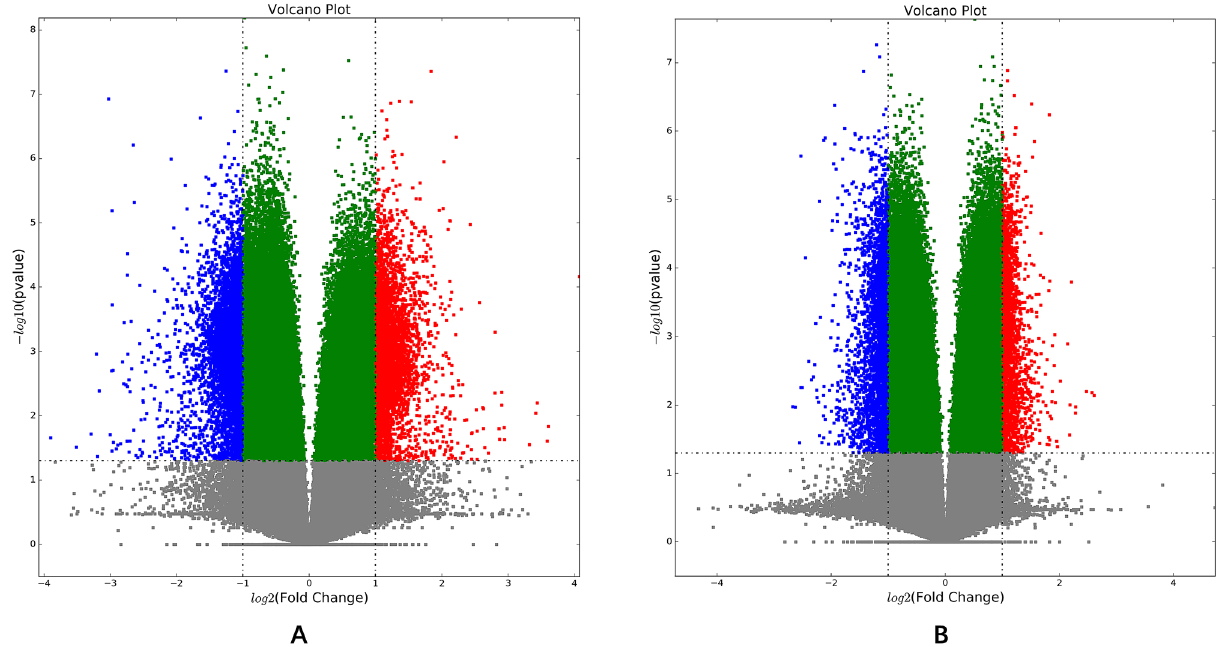
Figure 1. Volcano Plots. ( A ) Comparisons of differential DNA methylation sites between CD penetrating intestinal mucosal tissue with normal intestinal mucosal tissue; ( B ) Comparisons of differential DNA methylation sites between CD penetrating and non-penetrating intestinal mucosal tissue. Figures were performed with affy R package (Version 3.6.1, https:// www.r- proje ct.